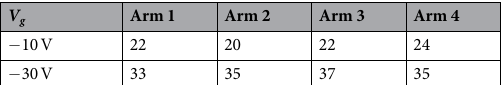
Table 1. Arm conductances (in μ S) at gate voltages V 10 four